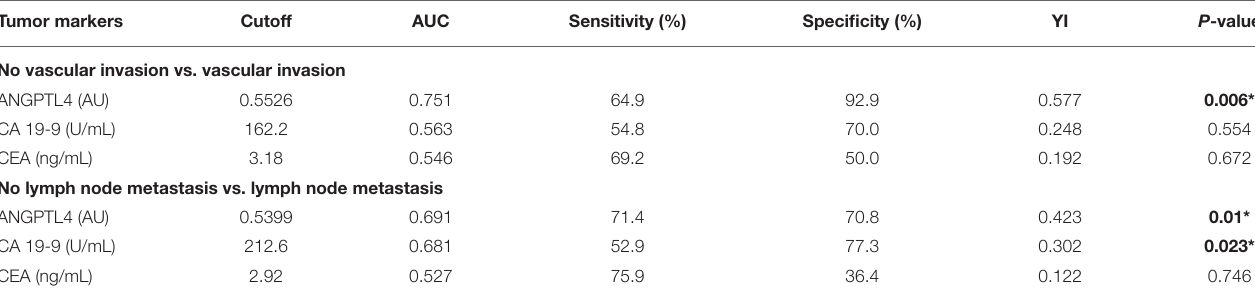
TABLE 3 | Predictive values of serum ANGPTL4, CA 19-9, and CEA levels for vascular invasion and lymph node metastasis of CCA patients, based on the optimal cutoff derived from ROC analysis and YI calculation. Tumor